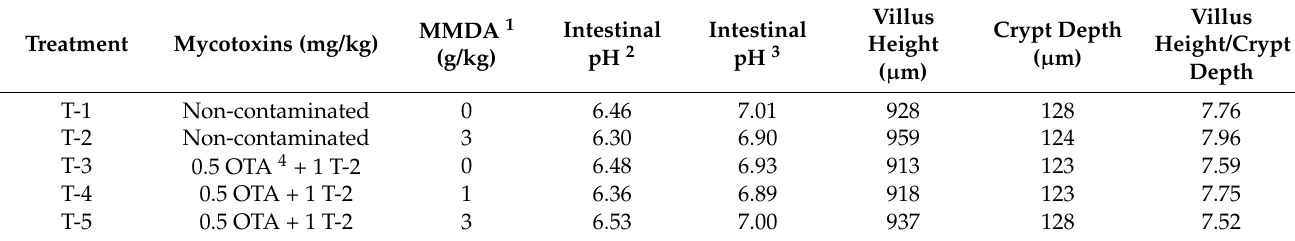
Table 9. The effects of feeding ochratoxin A (OTA) and T-2 mycotoxins and the addition of a binder mycotoxin product (MMDA) on intestinal pH and morphometry in broiler